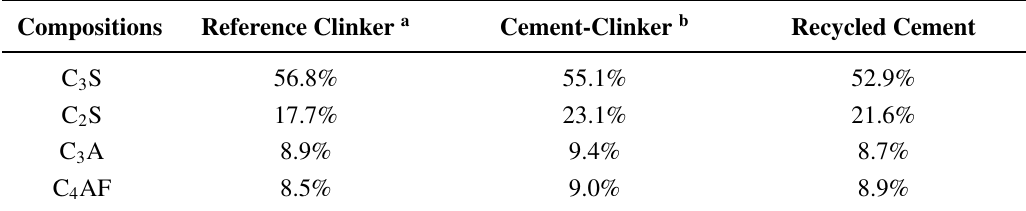
Table 6. Mineralogical compositions of the cement clinker and recycled cement.